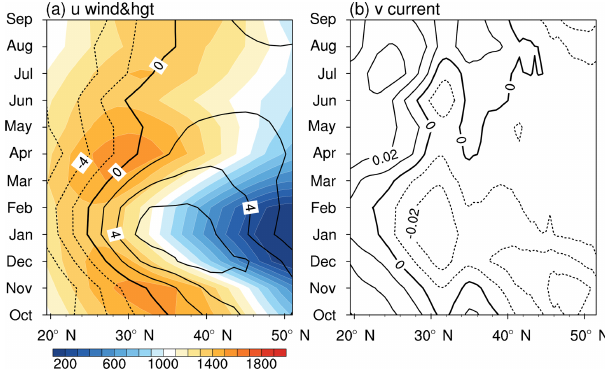
Figure 9. Latitude–time sections of (a) the climatological monthly mean geopotential height (shading; units: m 2 s − 2 ) and zonal wind speed at 1000hPa (black contour; units: ms − 1 ); (b) the climato- logical monthly mean meridional ocean currents (units: ms − 1 ). All variables are averaged zonally over 140 ◦ E–170 ◦